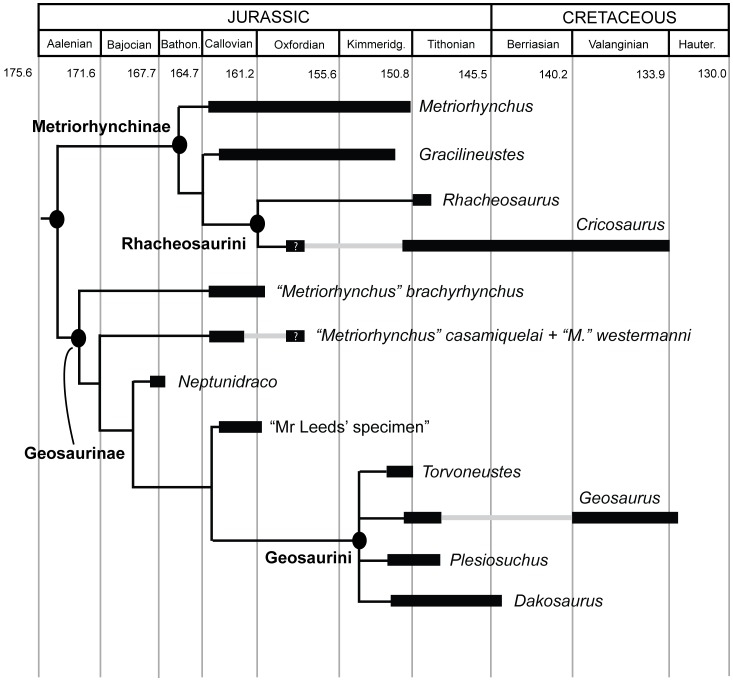
Genus-level evolutionary relationships of Metriorhynchidae, based on the phylogenetic analysis presented herein.The time-span of genera with question marks is uncertain, and the grey bars are range extensions.